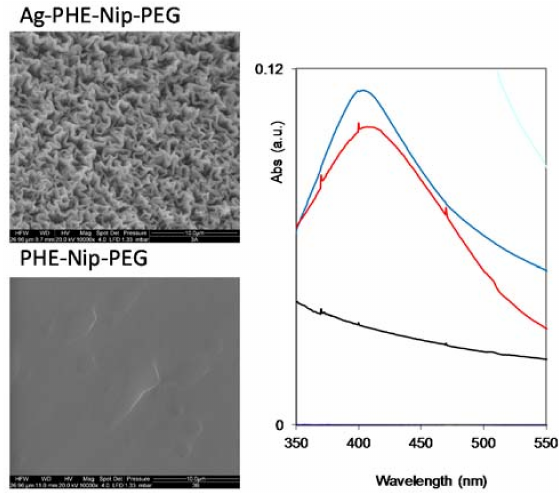
Figure 6. SEM images (scale bar 10 µ m) and UV-visible spectroscopy of the hydrogel PHE-Nip-PEG with (above) and without (below) silver nanoparticles. Hydrogel complexed with Ag + (black line), with silver nanoparticles (blue line) and after 24–48 h (red line).